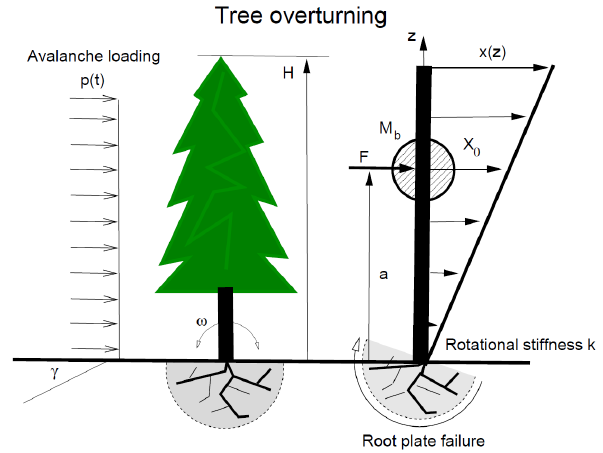
Figure 2. A tree of height H breaks in bending. The avalanche ex- erts a loading p(t) of known (but short) duration. The load acts in the centre-of-mass of the tree located a distance a from the ground. The mass of the linear distributed mass of the tree stem is m t and the lumped mass of the branches is M b . Tree deformation is given by the non-linear distribution x(z) .